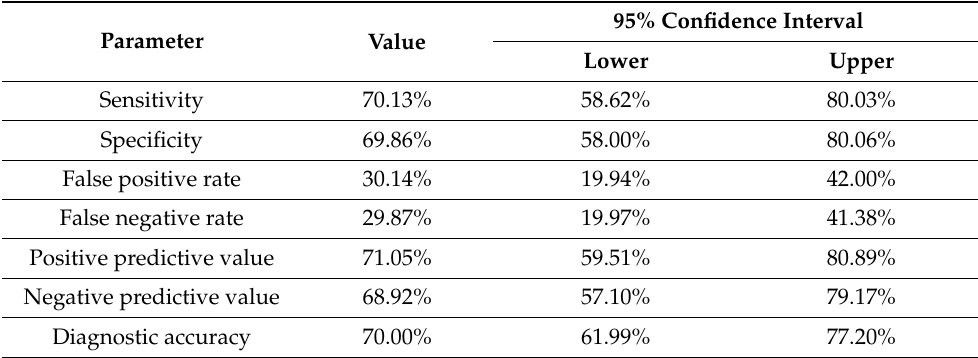
Table 10. Validity of ideal C-Reactive Protein value in predicting